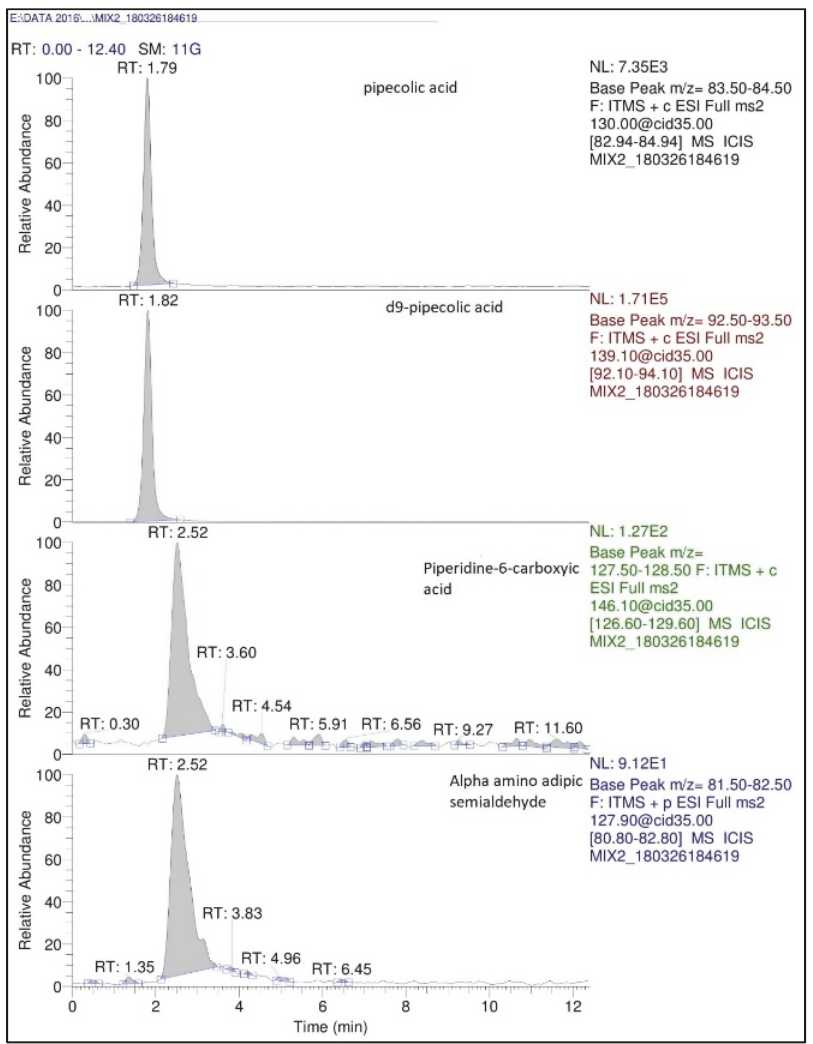
Figure 1: Optimized LC-MS chromatogram of 𝛼 -amino adipic semialdehyde, piperidine-6-carboxylicacid, and pipecolic acid in SRM